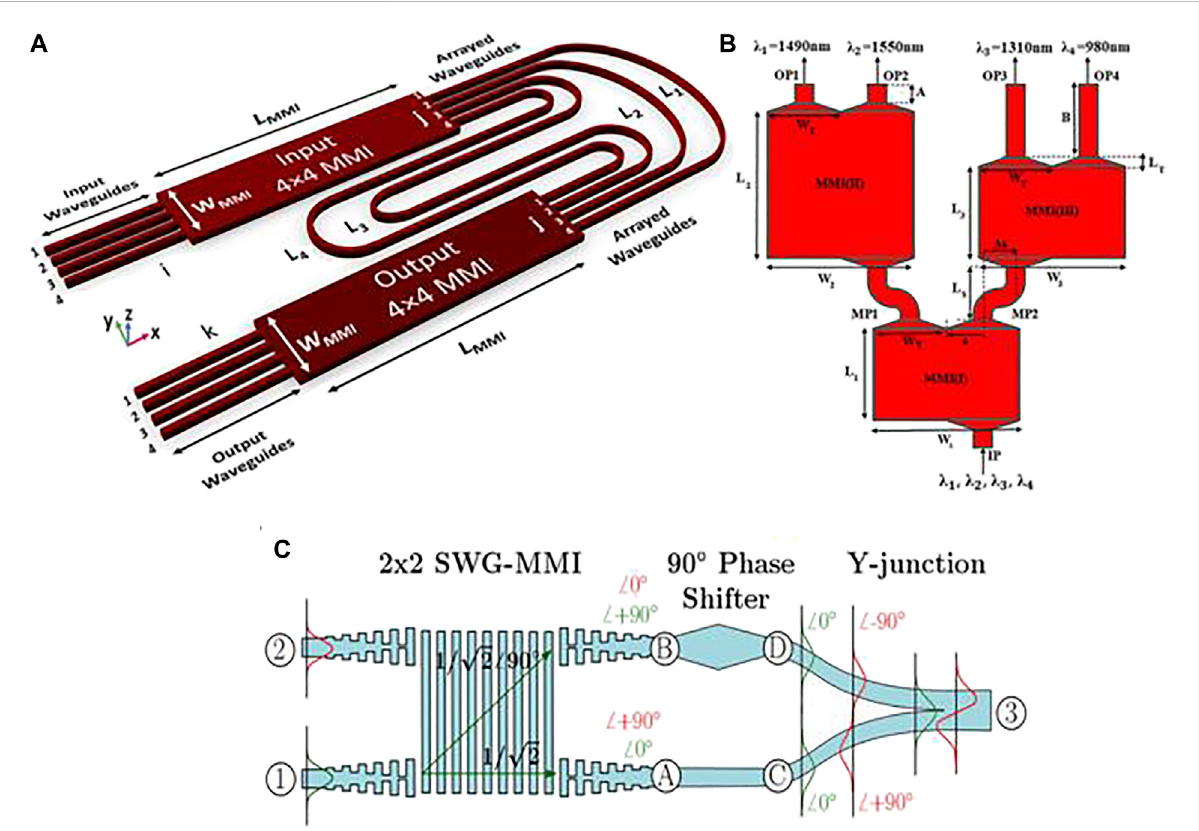
FIGURE 4 MMI coupling structure for WDM and MDM. (A) Two 4 × 4 MMIs are cascaded for WDM [112]. (B) Three 1 × 2 MMIs are cascaded for WDM [113]. (C) MMIbasedonSWGiscombinedwithy-branchtorealizemodeconversionandmultiplexing[116].Figurereproducedwithpermissionfrom: (A) ,© 2021,Institute ofElectricalandElectronicsEngineers(IEEE); (B) ,©2021,Springer; (C) ,©2018,Institute ofElectricalandElectronicsEngineers(IEEE).